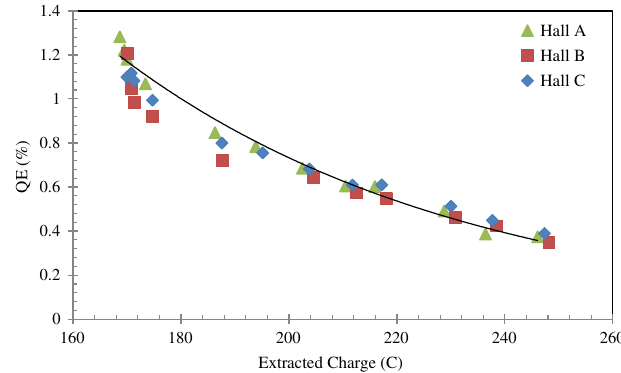
FIG. 5. (Color) A representative plot of daily QE measurements for each drive laser (one per experiment hall) vs extracted charge from the new inverted gun. The data represent QE measurements from one photocathode location, after having already extracted (cid:1) 170 C from previous locations (i.e., this explains the sup- pressed zero of the x axis). A simple exponential fit to the data indicates 1 =e charge lifetime of (cid:1) 70 C